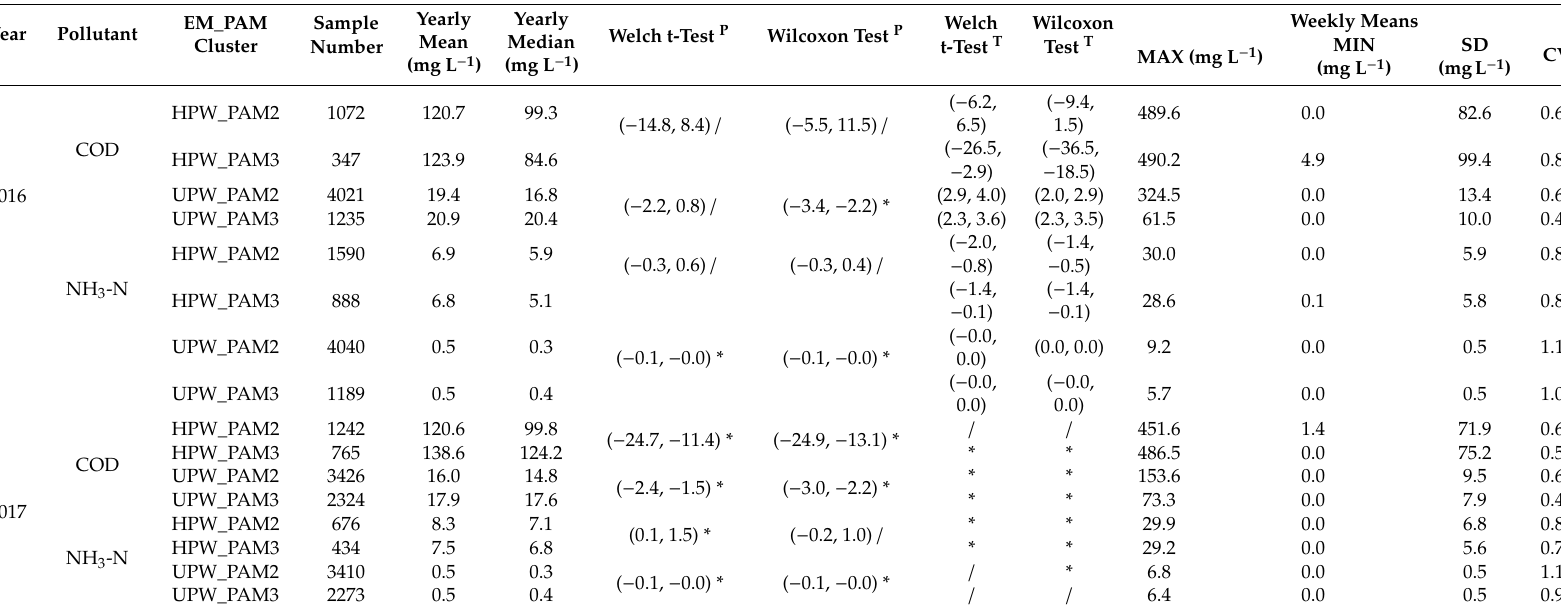
Table 1. Summary data for the weekly means of COD and NH 3 -N in the YRB wastewater in the di ff erent clusters in 2016 and